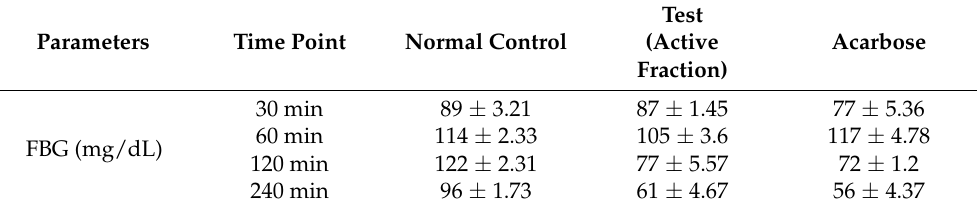
Table 4. Effect of active fraction (F4) on glucose-loaded hyperglycemic animals.